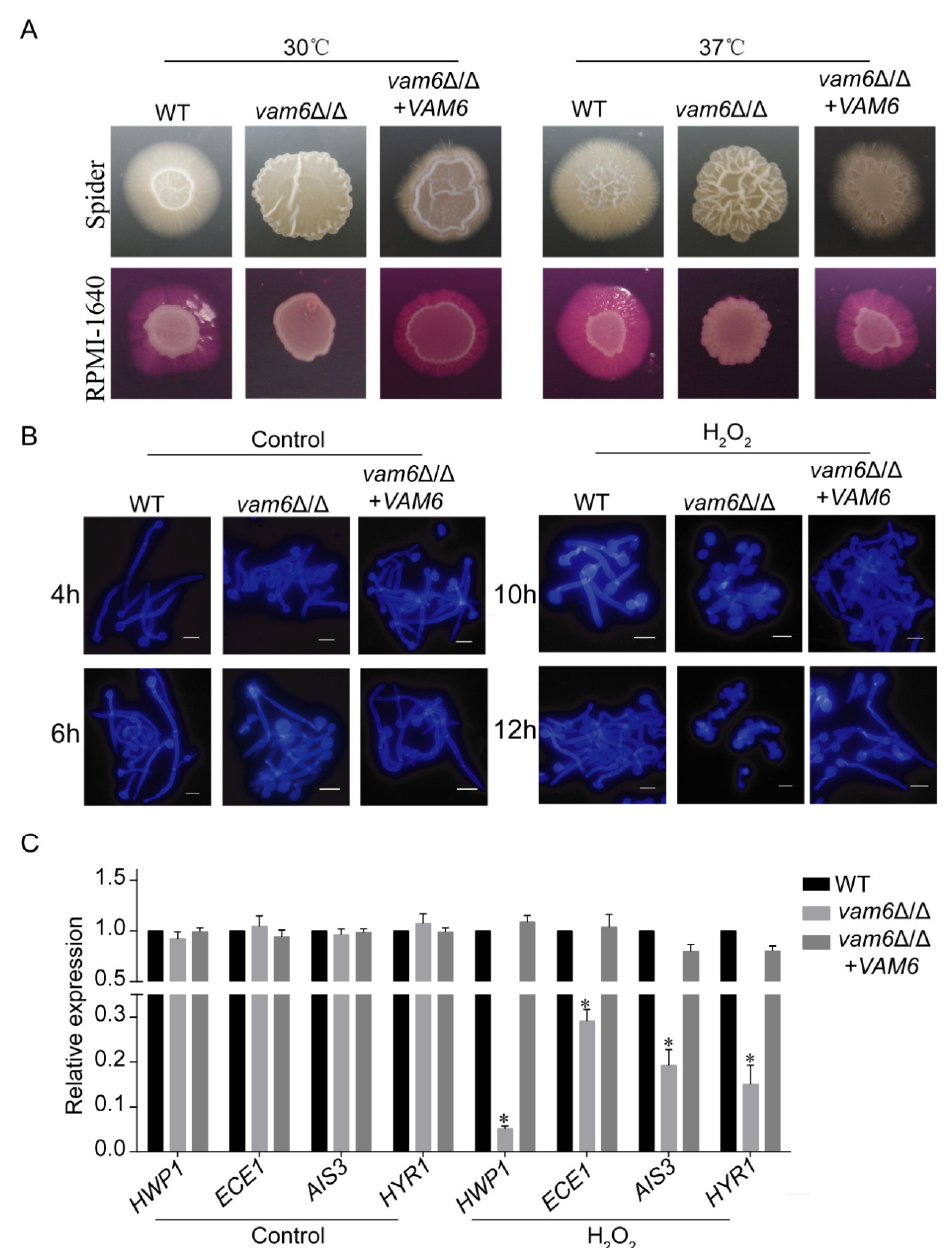
Figure 7. The effect of VAM6 deletion on hyphal development of C. albicans . ( A ) Hyphal development on the solid hypha-inducing media. The strains were spotted on the indicated agar plates and incubated at 30 °C or 37 °C for five days. ( B ) Hyphal development in the liquid RPMI-1640 medium in the absence of (Control) or in the presence of H 2 O 2 . Left, the cells were incubated in the medium at 37 °C for 2 h, 4 h, or 6 h, and stained by CFW for observation. Right, the strains were incubated in liquid RPMI-1640 containing 5 mM H 2 O 2 at 37 °C for 10 h or 12 h, and stained by CFW then observed. Bar = 5 μm. ( C ) Effect of VAM6 deletion on expression of hypha related genes. Cells were collected after treated by 5 mM H 2 O 2 in liquid RPMI-1640 medium for 1 h, and then RNA was extracted. The expression of AIS3 , ECE1 , HYR1 , and HWP1 were measured by RT-PCR using ACT1 as the normalization gene. The relative measurement was respectively under control and H 2 O 2 conditions. This value represents the mean ± SD with three replicates. * indicates a significant difference between the mutant and the control strains ( p < 0.05).